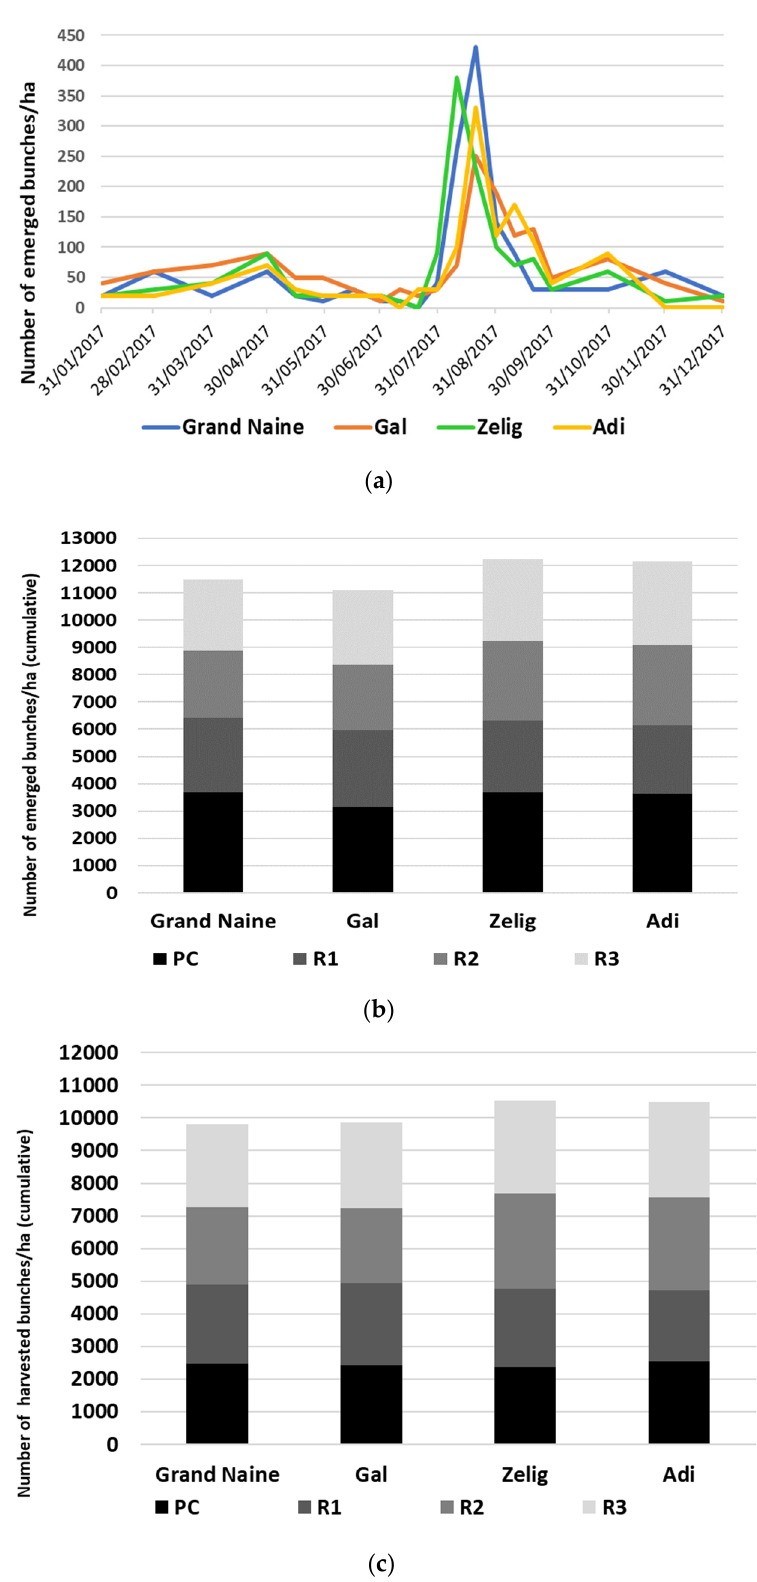
Figure 1. Reproductive traits. ( a ) Bunch emergence distribution in cycle R1 expressed in number of bunches on each of the bunch emergence dates (dd/mm/yyyy), ( b ) cumulative number of emerged bunches per hectare over PC–R3 crop cycles, and ( c ) cumulative number of harvested bunches per hectare over PC–R3 crop cycles.